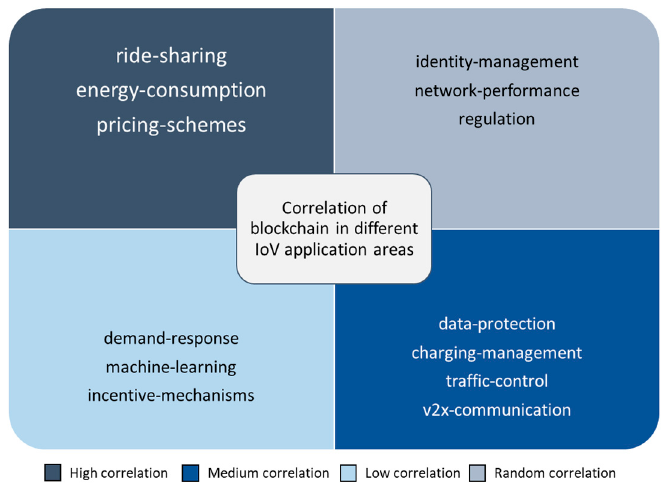
Figure 8. Matrix of blockchain in different IoV-associated areas. Table 4. Association of blockchain in different IoV application areas: results. Blockchain Platforms Used in